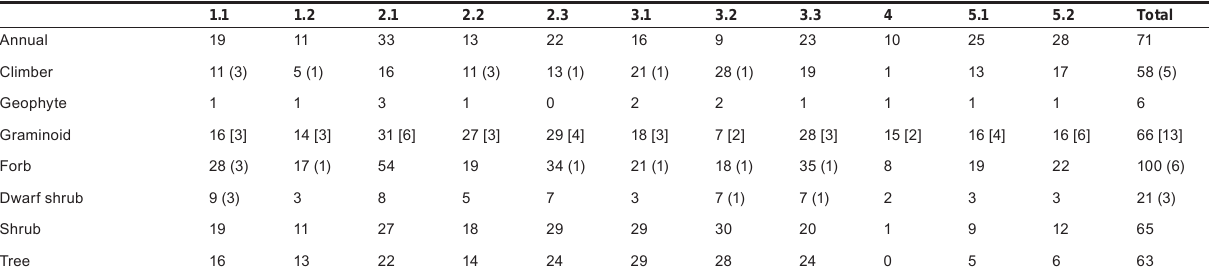
Table 5 Plant species richness of different growth forms in each of the plant sub-communities of the Nkhuhlu exclosures